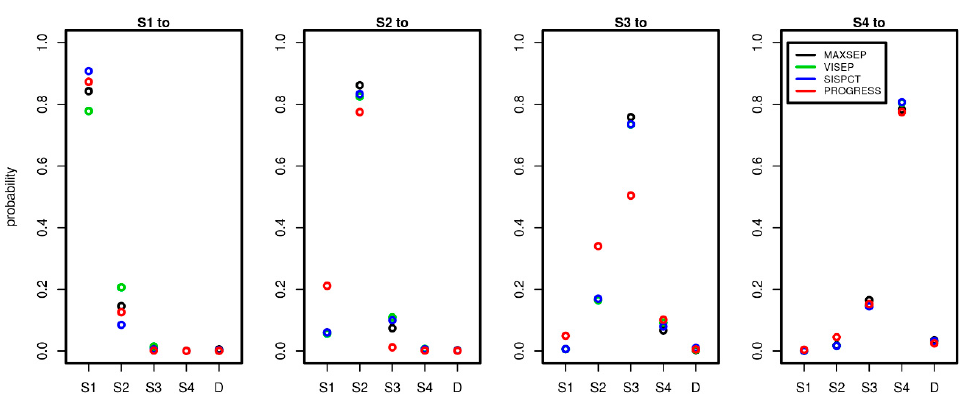
Figure 5. Comparison of transition probabilities between disease states across studies and possible state transitions. To estimate the probabilities, we used 5 observation days for PROGRESS and 15 observation days for all SepNet studies. Each panel shows the daily transition probabilities from one disease state (see panel title) to the other possible disease states shown on the x-axis. Good agreements of transition probabilities between studies were observed.